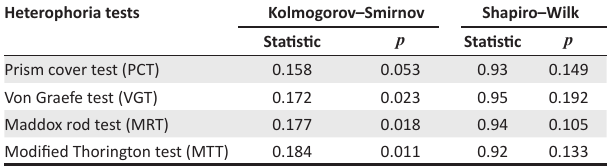
TABLE 1: Tests for data normality for four tests for near horizontal heterophoria. Heterophoria tests